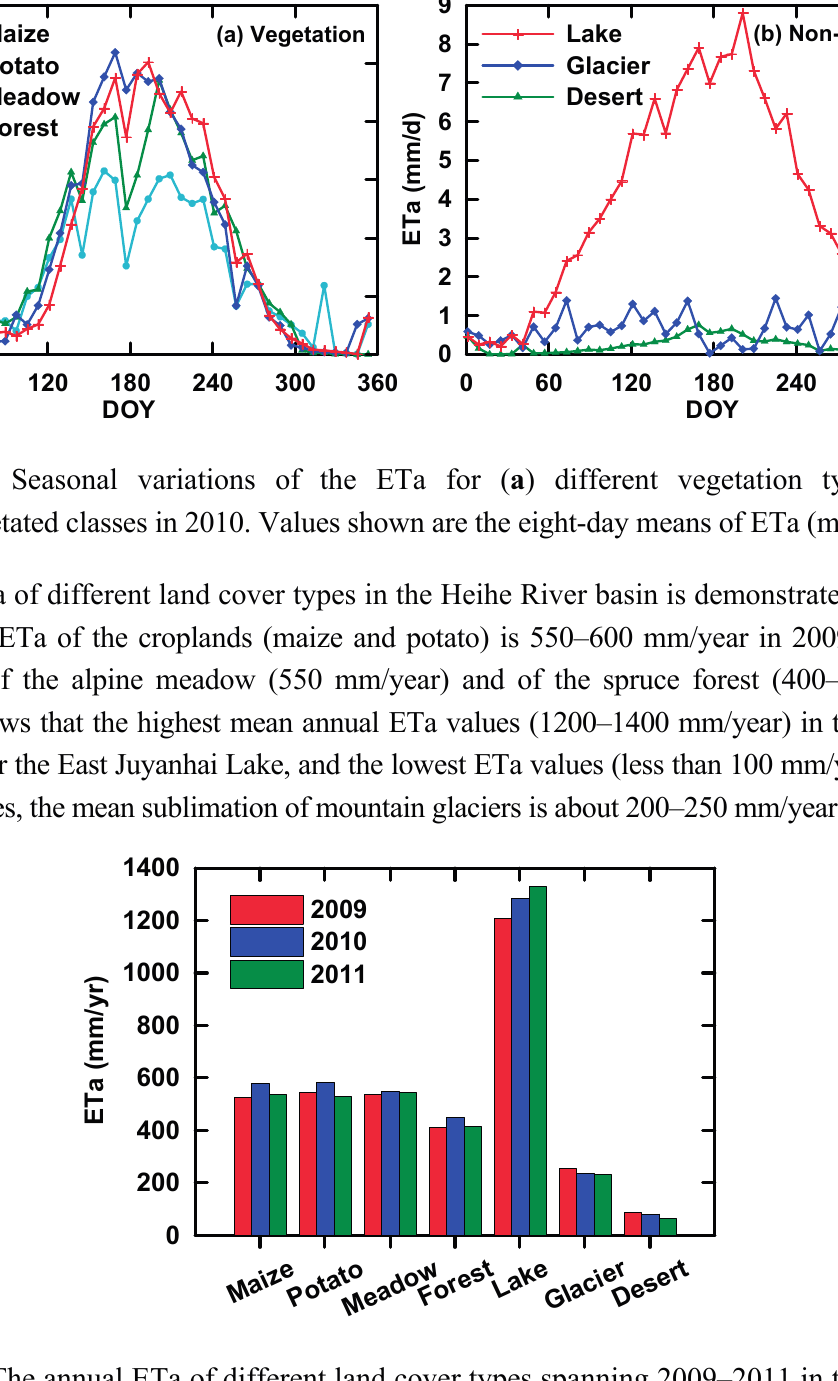
Figure 11. The annual ETa of different land cover types spanning 2009–2011 in the Heihe River